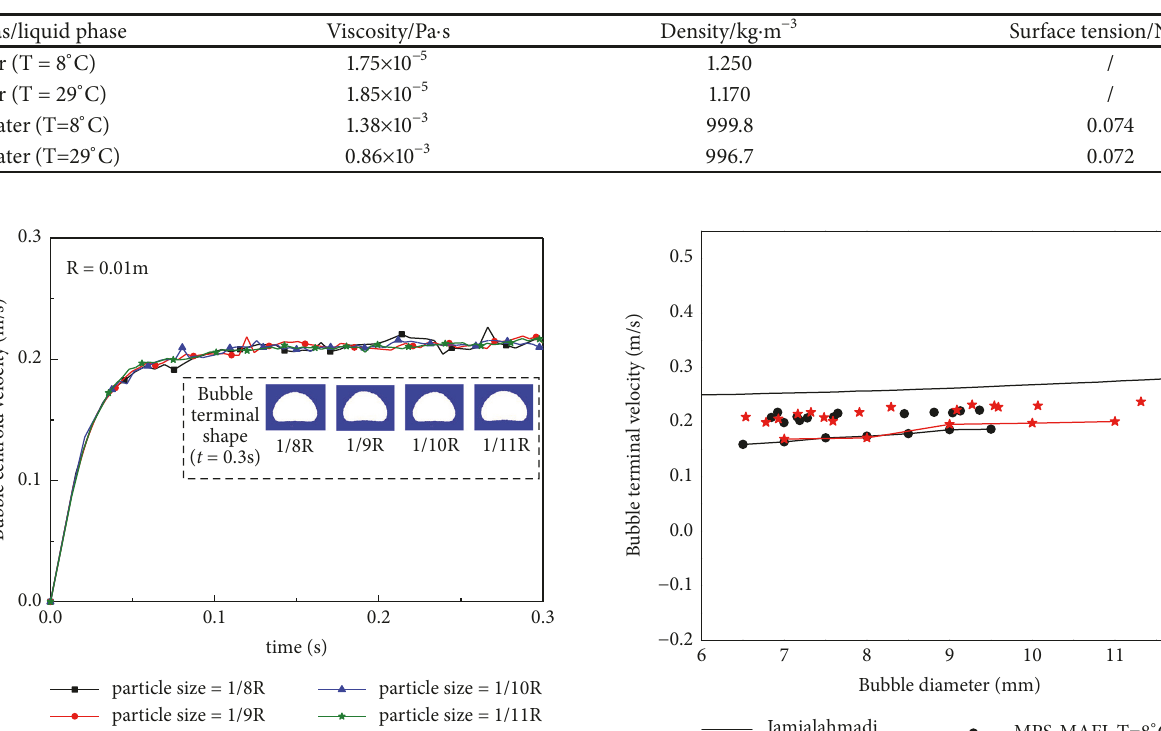
Table 1: Physical property parameters of the gas-liquid phase.